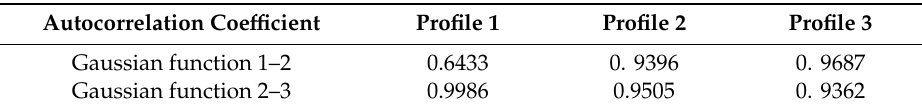
Figure 7. The residual of one to three Gaussian fitting functions using 0.2 m width lags. The bar chart shows the difference between the Z-value of points in the 99 % confidence interval of three Gaussian fitting functions and the fitting model. Table 2. The correlation coefficient of the residual.